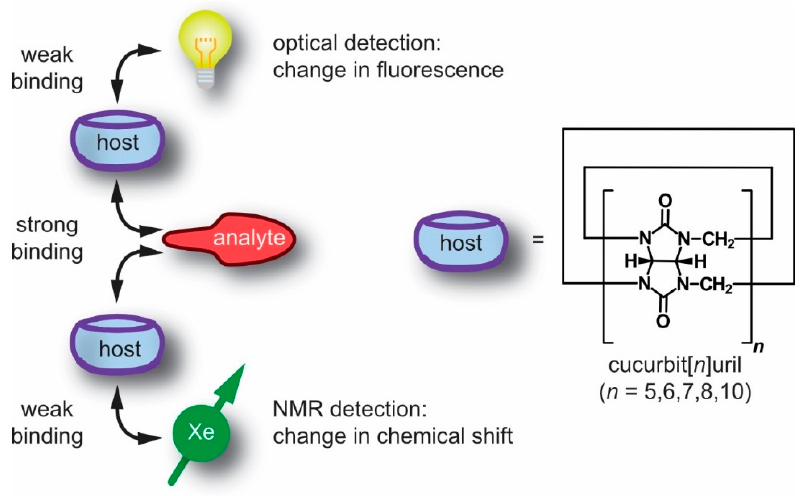
Figure 1. Example for extending a supramolecular-based detection assay concept from fluorescence detection to NMR readout. A fluorescent dye that binds to a molecular host is displaced upon formation of the analyte host complex. The same can be implemented with 129 Xe atoms that bind to the cavity. In both cases, no label is directly attached to either of the supramolecular interaction partners.